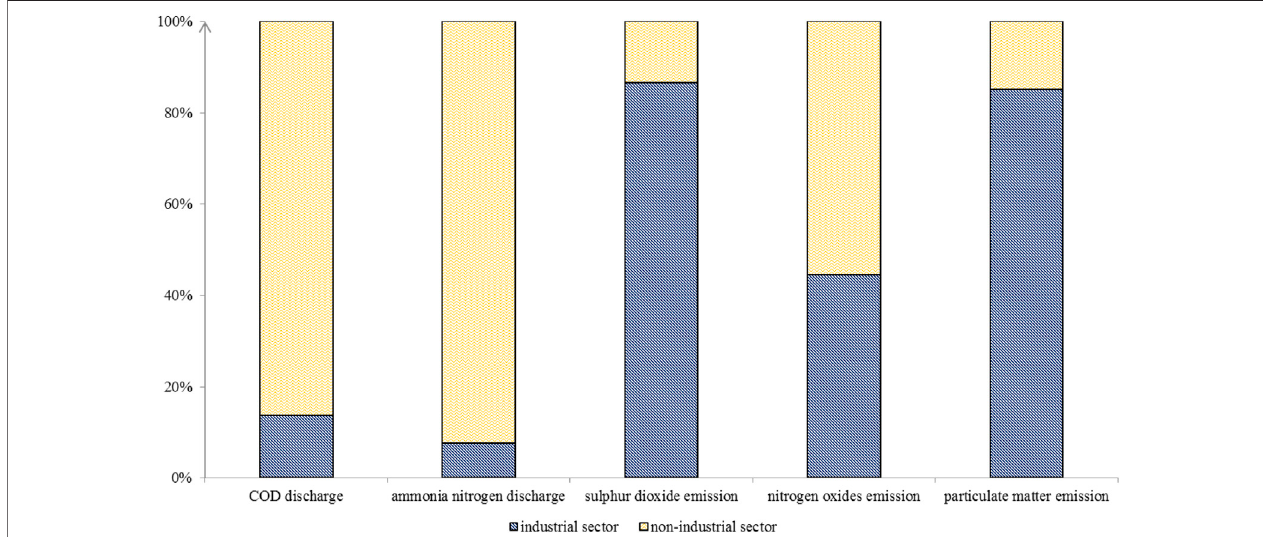
FIGURE 8 | Composition of some pollutants ’ discharged into water and emitted into the atmosphere in China in 2019. Source: The author searched the total quantities ofpollution and the number in the industrial sector in the China Statistical Yearbook on Environment 2020 and calculated pollution in the non-industrial sector,